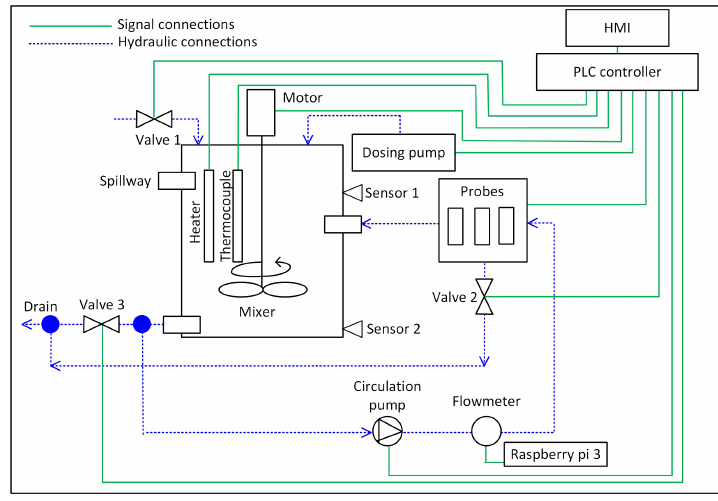
Figure 1. General scheme of the analytical device.